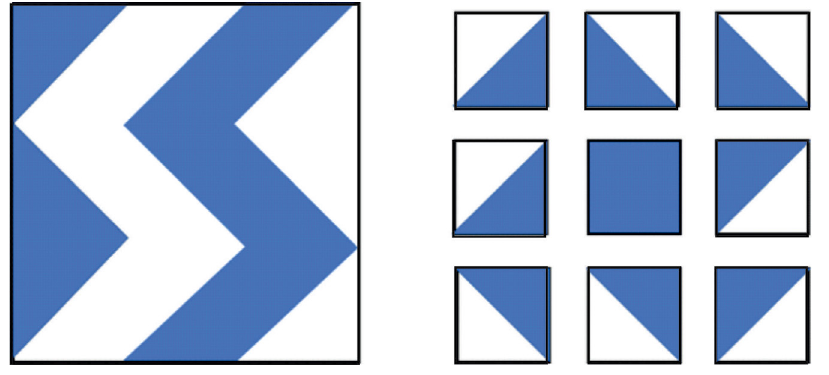
Figure 4. Example of a block design test. Participants are asked to move the blocks on the right to create the pattern on the